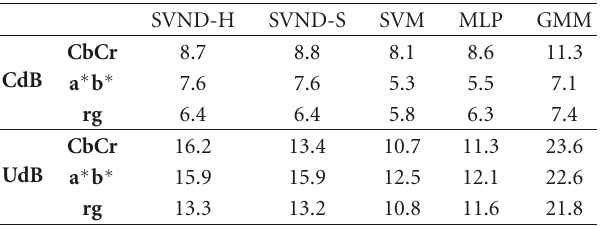
Table 5: All values of HTER (%).